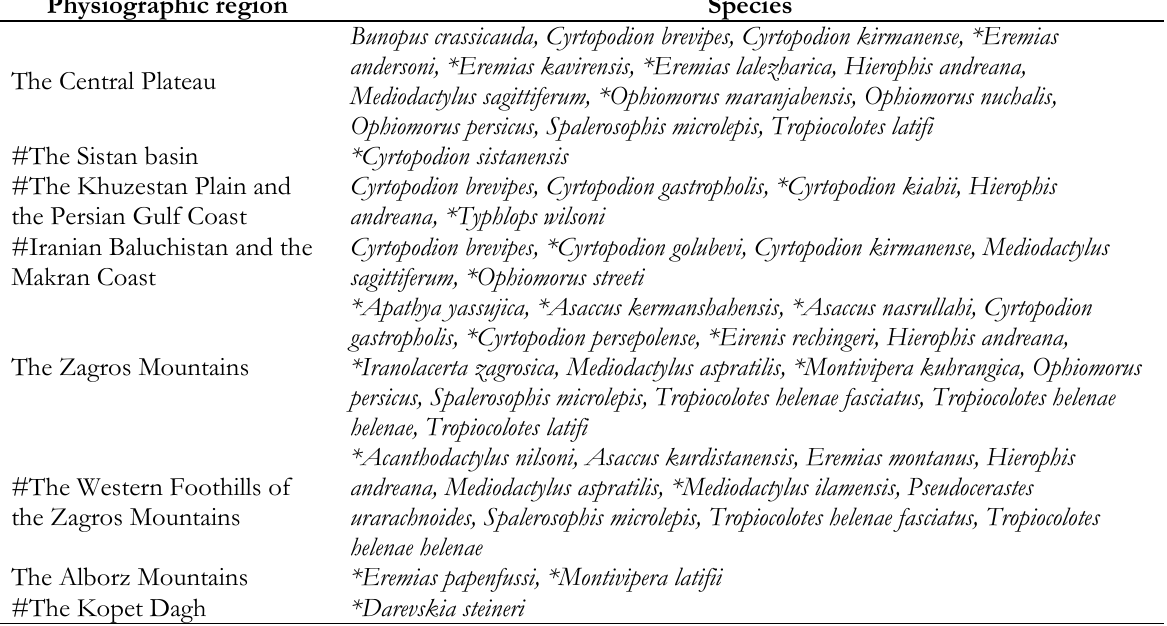
TABLE 2. – Recorded distribution of the endemics within the physiographic regions. * = endemic recorded alone in this physiographic region, # = physiographic region having joint boundary with neighboring